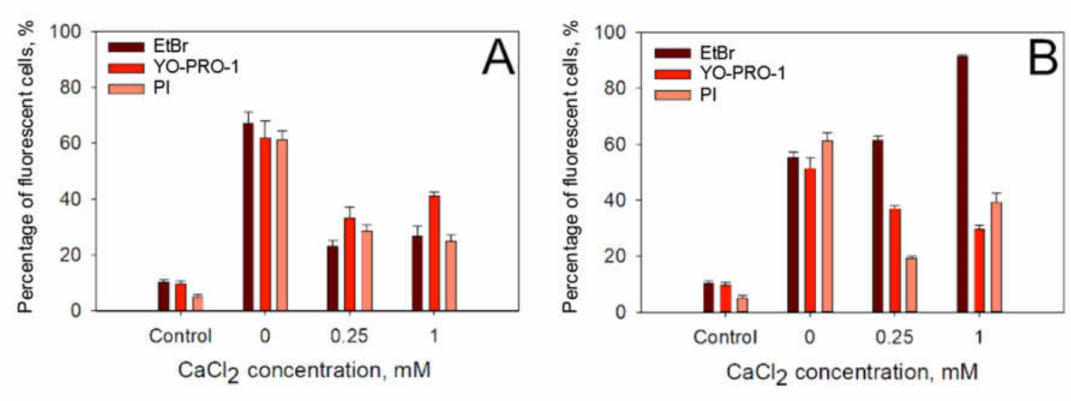
Figure5. DependenceofPI,EtBrandYO-PRO-1electrotransfere ffi ciencyonthepresenceofextracellular calcium after treatment with 1 × 1400 V / cm strength and a 100- µ s duration electric pulse ( A ) on the presence of extracellular calcium after treatment with 10 × 14 kV / cm strength and 200-ns duration electric pulses at 1 Hz of repetition frequency ( B ). Fluorescence was measured 15 min after the applied electric field. The error bars represent the mean ± standard error of mean of n = 6 experimental replicates.